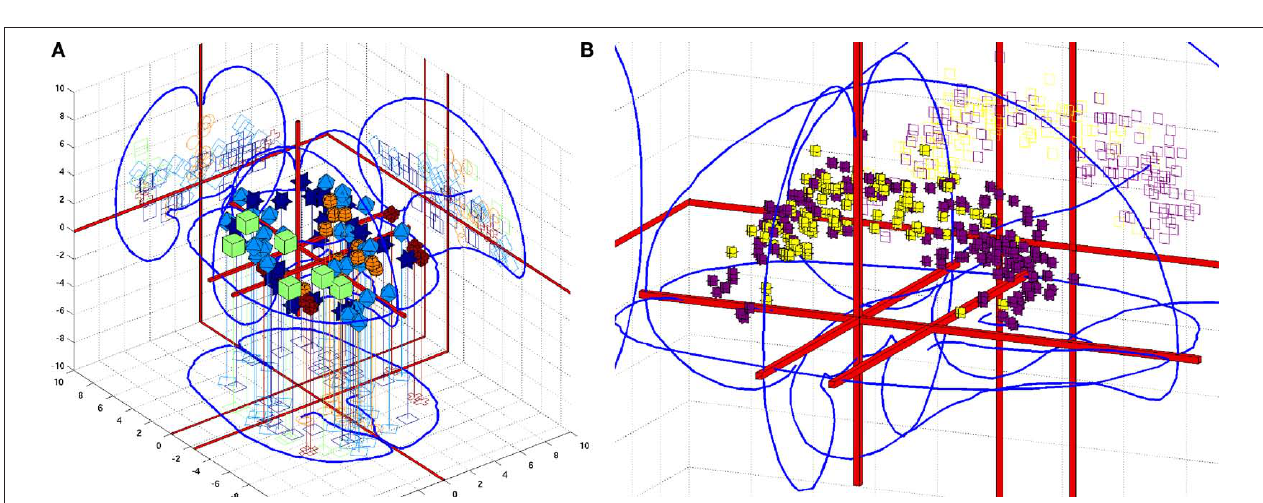
FIGURE 3 | Two examples of coordinates in a 3D corner cube visualization. (A) Coordinates from the fi ve studies in the Brede Database authored by Edward T. Bullmore. The 3D glyphs have type and color according to paper: Dark blue (Phillips et al., 1997), light blue (Phillips et al., 1998), light green boxes (Bullmore et al.,